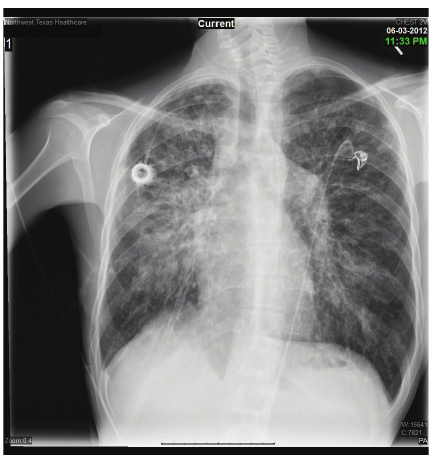
Figure 1: Admission chest X-ray showing right perihilar alveolar infiltrates superimposed on chronic pulmonary infiltrates.